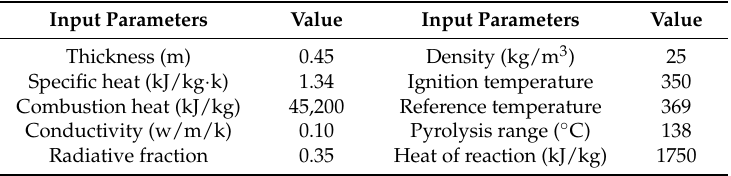
Table 4. Material properties and input parameters.